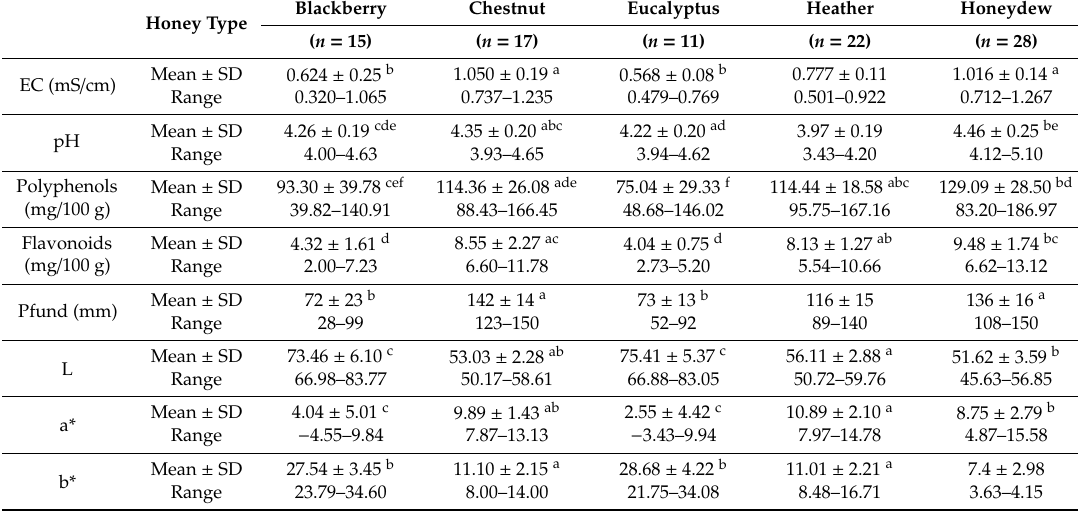
a–h : same letters type indicate equality between the values for each parameter shown in the table. EC: electrical conductivity. L represents lightness (L = 0, black, and L = 100, colorless), a* green / red color component (a* > 0, red, and a* < 0, green), and b* blue / yellow color component (b* > 0, yellow, and b* < 0,